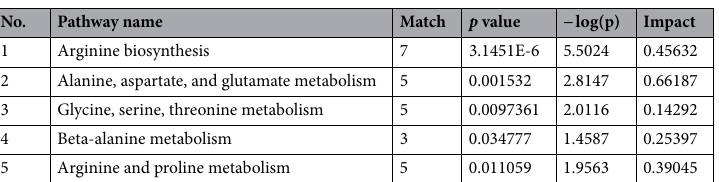
Table 2. Identification of oil palm pathways altered due to BSR disease. These pathways have p value < 0.05 and impact factor > 0.1.